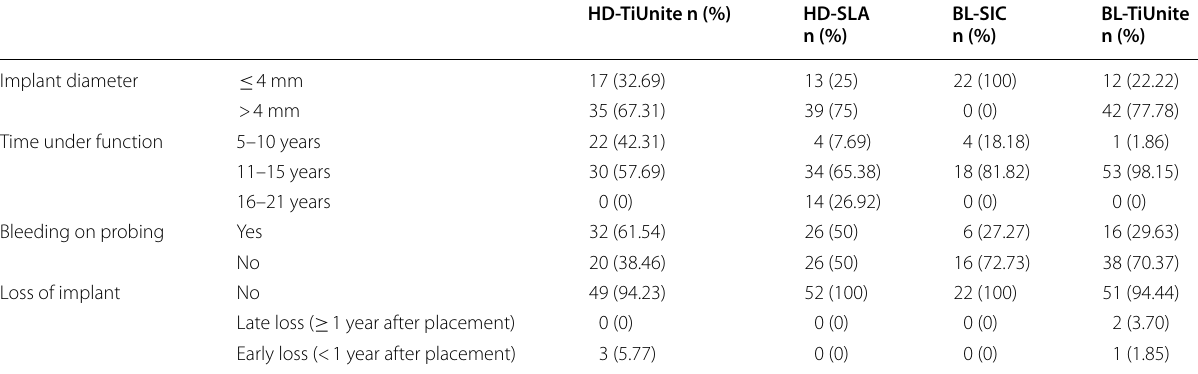
Table 1 Descriptive of implant characteristics, time under function, presence of bleeding on probing and implant loss